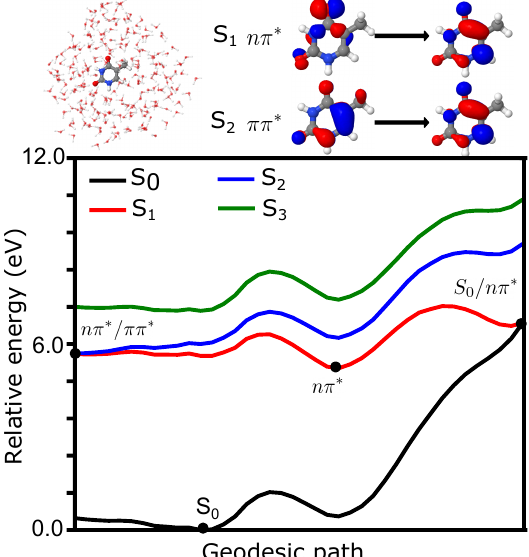
Figure 5. Photochemistry of thymine in water. ( top , left ) Schematic structure of thymine and water QM/MM model. ( top , right ) Main character of the transitions representing the first and second singlet excited states. ( bottom ) Geodesic path connecting the conical intersections between S 0 / n π ∗ , S 0 / ππ ∗ and n π ∗ / ππ ∗ as well as S 0 and n π ∗ minima. Energies (in eV) have been computed at the TDA-TDBH&HLYP/6-31G*